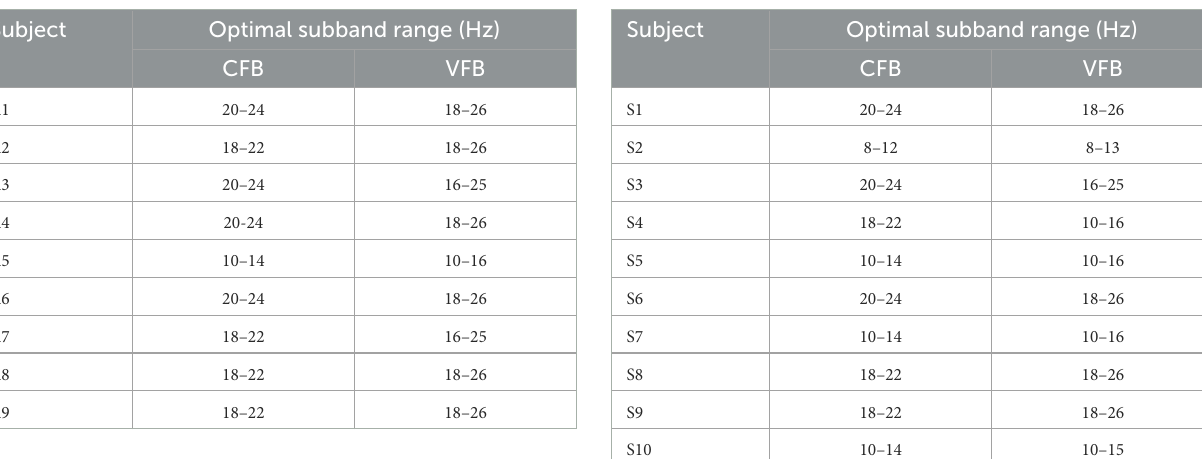
TABLE 5 Optimal subband range of subjects in Dataset 1. TABLE 6 Optimal subband range of subjects in Dataset